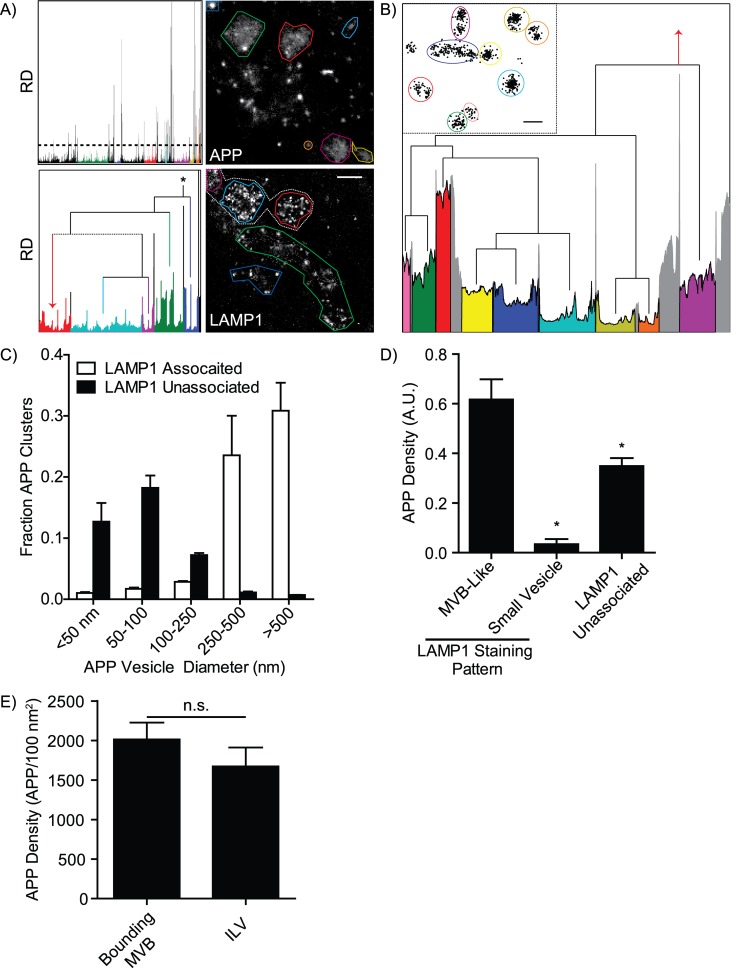
Identification of lysosomes and multivesicular bodies using the OPTICS algorithm.(A) Top: APP clusters were identified as “valleys” between RD “peaks” exceeding a static RD value (dotted line), and Bottom: LAMP1 clusters identified using a hierarchal segmentation approach. Select clusters are highlighted by colored region of the RD plots (left) and are circled by equivalent colored lines in the GSDM images (right). (B) A full hierarchal segmentation of the red LAMP1 cluster from panel A, demonstrating the nested hierarchal structure typical of multivesicular bodies. Insert plots the position of individual LAMP1 molecules within the cluster; colored circles correspond to putative intraluminal vesicles identified by the equivalent colored regions in the segmented RD plot, red arrow indicates where the RD plot joins the larger RD plot from panel A. (C) Comparison of APP cluster size and the association of APP clusters with LAMP1. (D) Quantification of APP density in LAMP1 clusters identified by OPTICS and separated based on whether the APP was associated with MVB-like, small lysosomal, or LAMP1-negative vesicles. (E) Quantification of APP density in the total (Bounding MVB) and intraluminal vesicle (ILV) portions of the MVB-like LAMP1 clusters. All images are representative of three experiments, a minimum of 4 images per experiment. Data are presented as mean ± SEM, scale bars are 500 nm (A) and 150 nm (B). * = p < 0.05 compared to MVB-like, n.s. = not significantly different.